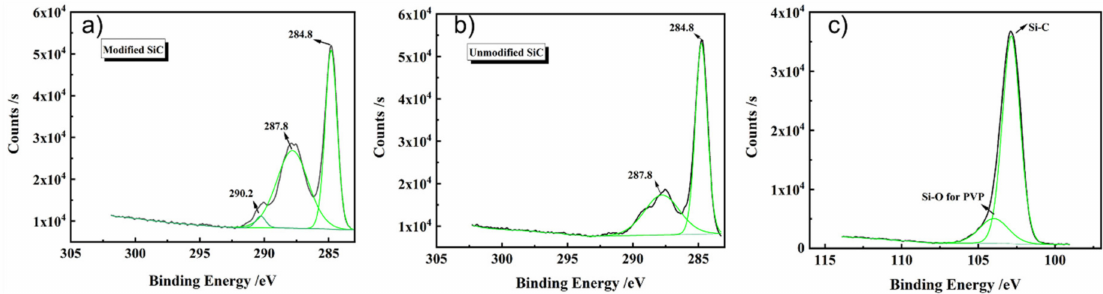
Figure 9. High-resolution XPS spectra: ( a ) C 1s of PVP-adsorbed SiC powder, ( b ) C 1s of unmodified SiC powder, and ( c ) Si 2p of PVP-adsorbed SiC powder.